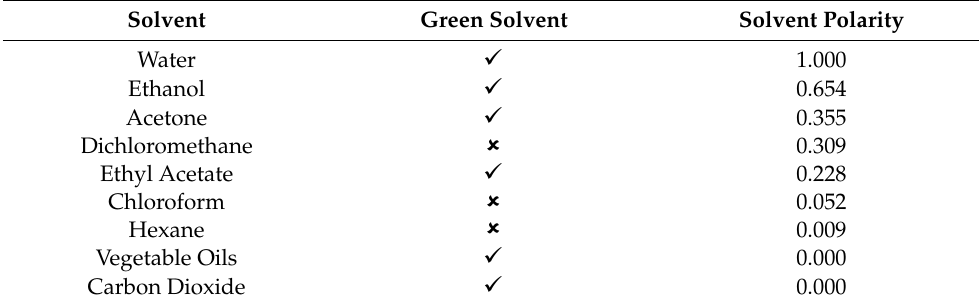
Table 1. Solvent types and polarity [27].